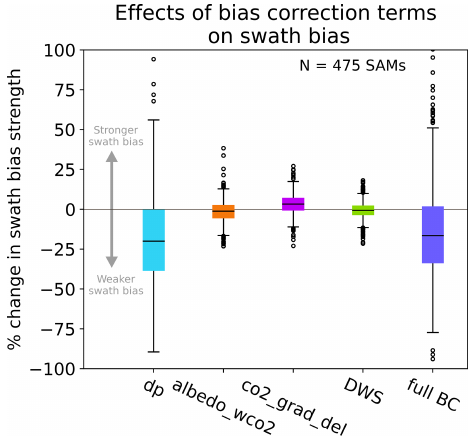
Figure 20. SB response to individual v10 bias correction terms for 475 v10 SAMs whose sb_flag = 1 prior to filtering and bias correc- tion. This set of SAMs extends beyond the time period used in the vEarly